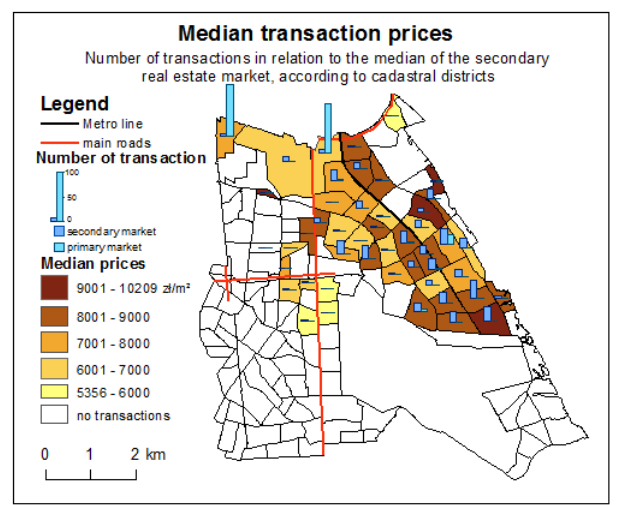
Fig. 12. Number of transactions on the primary and secondary residential real estate markets in Ursynów in relation to the median of the secondary real estate market, according to cadastral